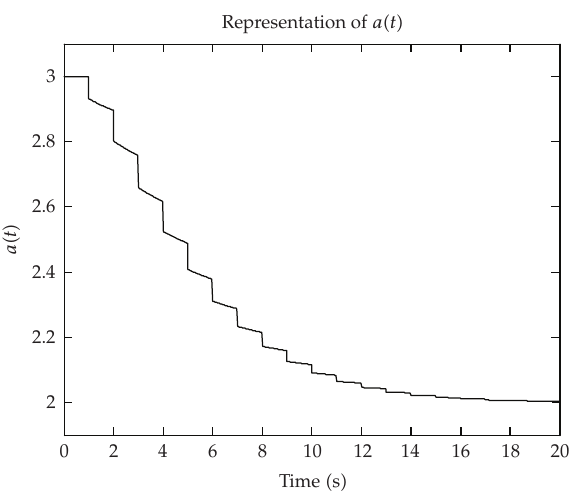
Figure 6: Graphical representation of a (cid:4) t (cid:5) .